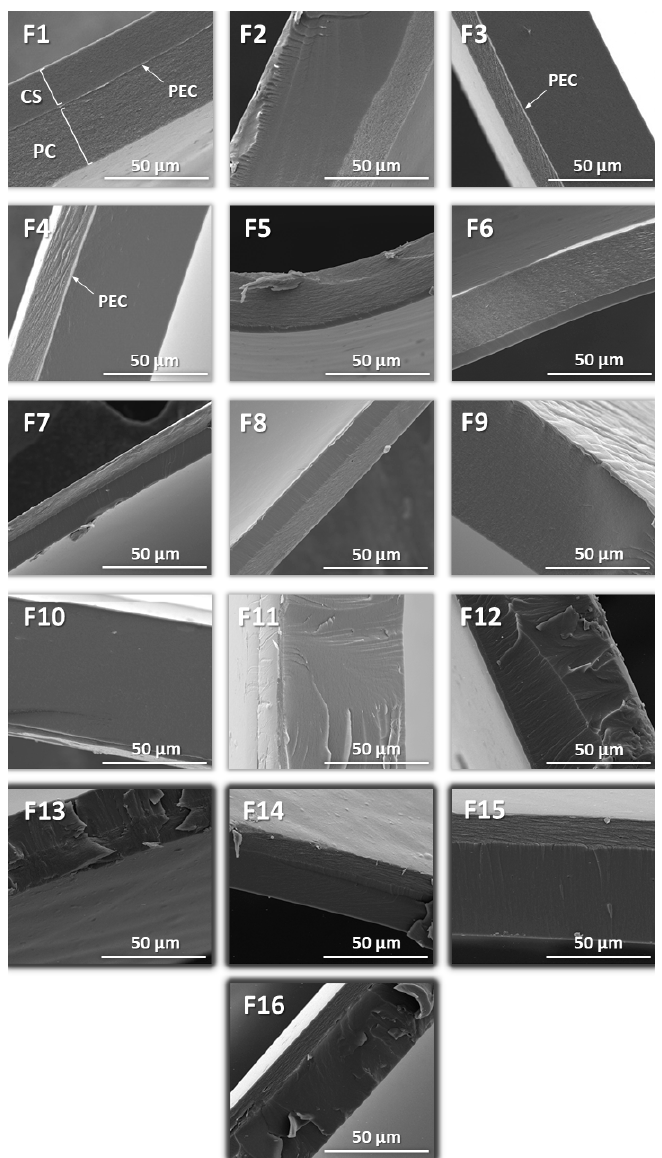
Figure 3. Representative SEM images of F1–F16 films under 3000× magnification.